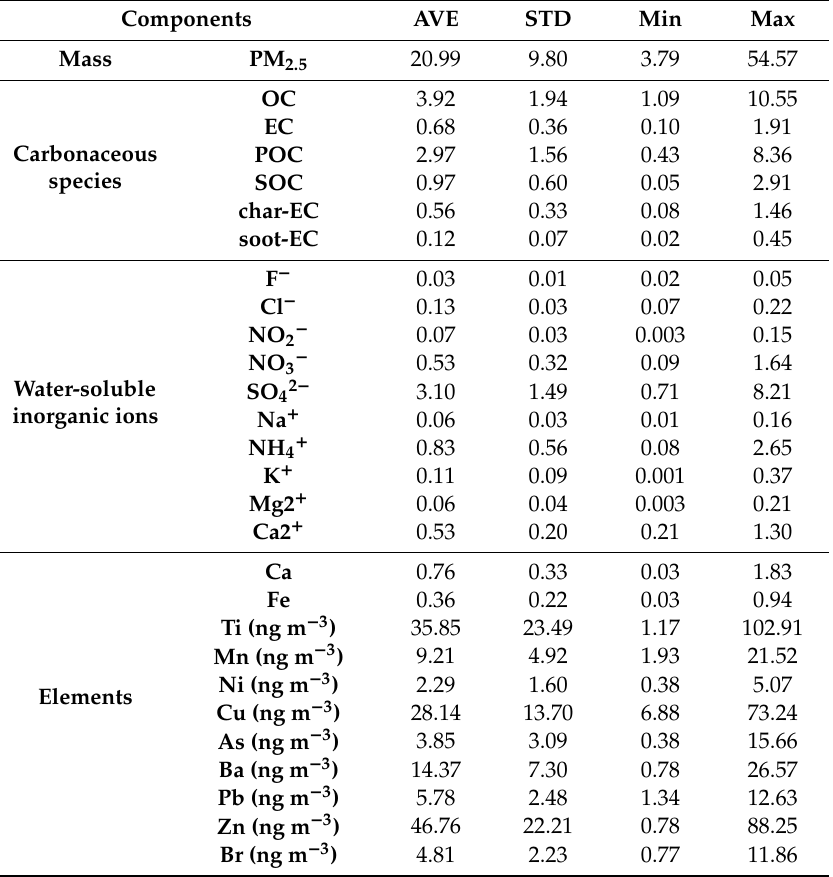
Table 1. Arithmetic averages, standard deviations, minimum and maximum values for mass and chemical components during the sampling time (unit: µ g m − 3 ). PM: particulate matter; OC: organic carbon; EC: elemental carbon; POC: primary OC; SOC: secondary